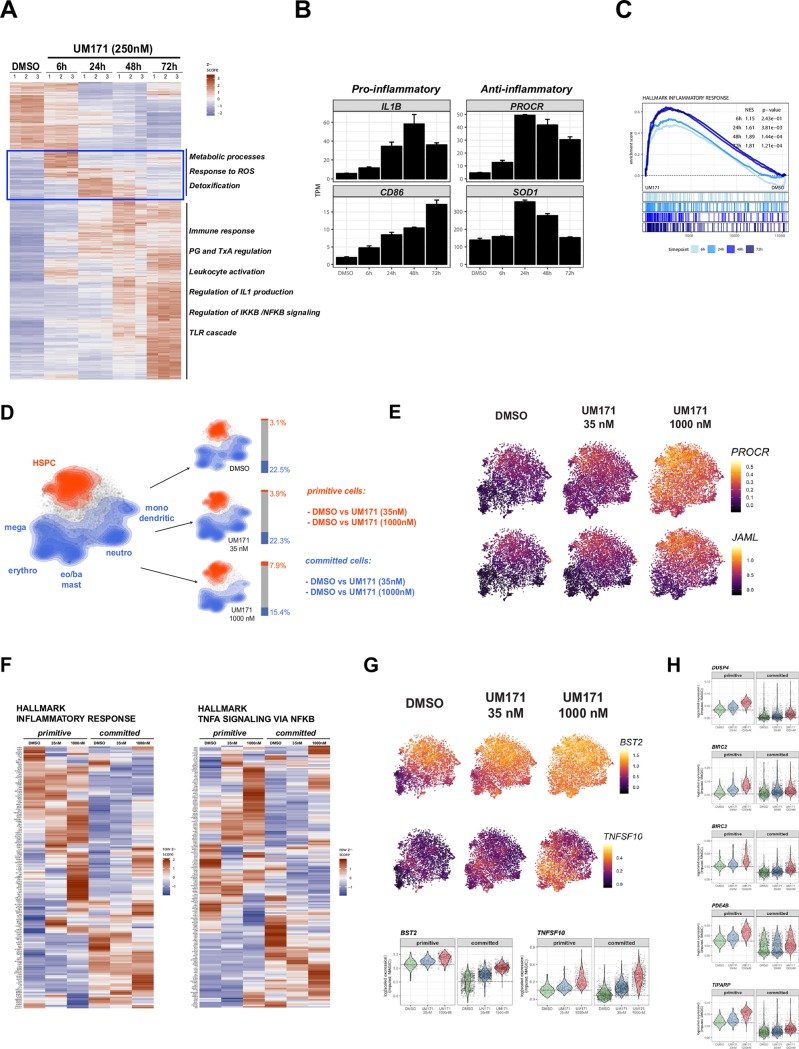
UM171 exposure induces inflammatory gene signature.A: Heat-map of differentially expressed transcripts after 6, 24, 48 and 72hrs of UM171 treatment in OCI-AML5 cell line (>2-fold change, q-value < 0.0001 at any timepoint compared to untreated). B: Examples of pro-inflammatory (IL1b and CD86) and anti-inflammatory genes (PROCR and SOD1) expression changes upon UM171 treatment in OCI-AML5 cells. C: GSEA plots showing enrichment for genes associated to inflammatory responses in OCI-AML5 cell line (250nM, 6, 24, 48 and 72hrs exposure).D: Topology of primitive (red) and committed (blue) cell subsets on top of t-SNE projection in either the combined dataset (left panel) or separated based on treatment (right panels). Barplots next to t-SNE graphs summarize cellular compositions of individual treatments into primitive/committed subsets. E: t-SNE heatmap of representative stem cell associated genes PROCR (also called EPCR or CD201) and JAML; imputed data (MAGIC). F: Heatmap summaries (average values) of selected inflammation associated genesets (corresponding GSEA in S2E Fig). G: t-SNE heatmap and corresponding violin plots (lower panel) of representative inflammatory genes modulated in response to UM171 in both primitive and committed cells (BST2 and TNFSF10); imputed data (MAGIC). H: Violin plots illustrating expression distribution of candidate genes associated to TNFa/NFkB pathway across primitive and committed subsets. Note the preferential UM171 mediated modulation of these candidate genes in primitive subset. p≤0.05.